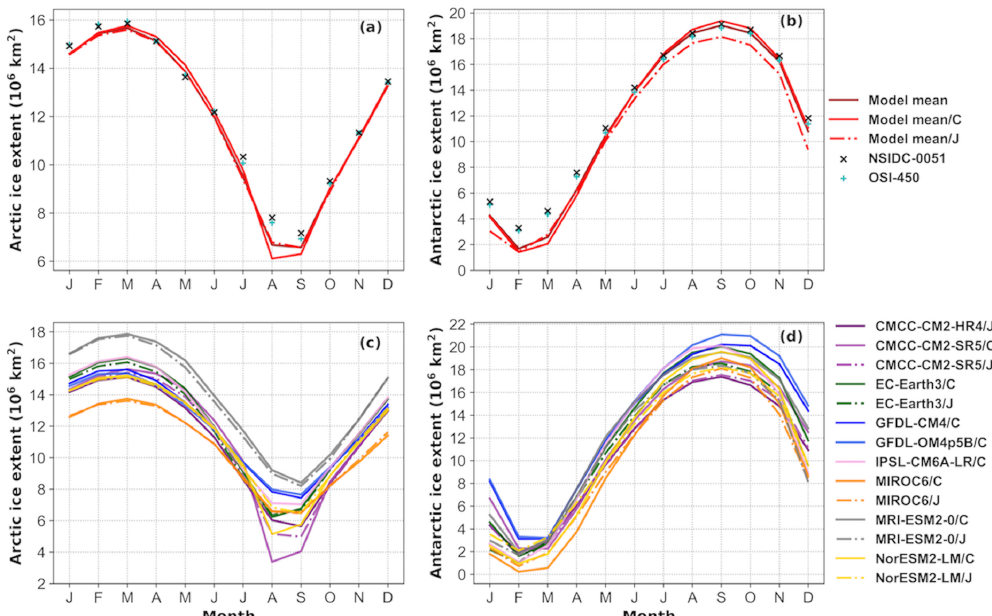
Figure 3. The 1980–2007 mean seasonal cycle of ice extent (10 6 km 2 ) from 14-model mean (solid brick red), five-model mean under OMIP1 and OMIP2 protocols (solid red and dash-dotted red), NSIDC-0051 (black × ), and OSI-450 (cyan + ) in the (a) Arctic and (b) Antarctic. The five-model mean is from CMCC-CM2-SR5, EC-Earth3, MIROC6, MRI-ESM2-0, and NorESM2-LM. The mean seasonal cycle from 14 model outputs under OMIP1 (/C) and OMIP2 (/J) protocols are shown in panels (c) and (d) , and the model outputs under OMIP2 protocol from the five models are in dash-dotted lines.